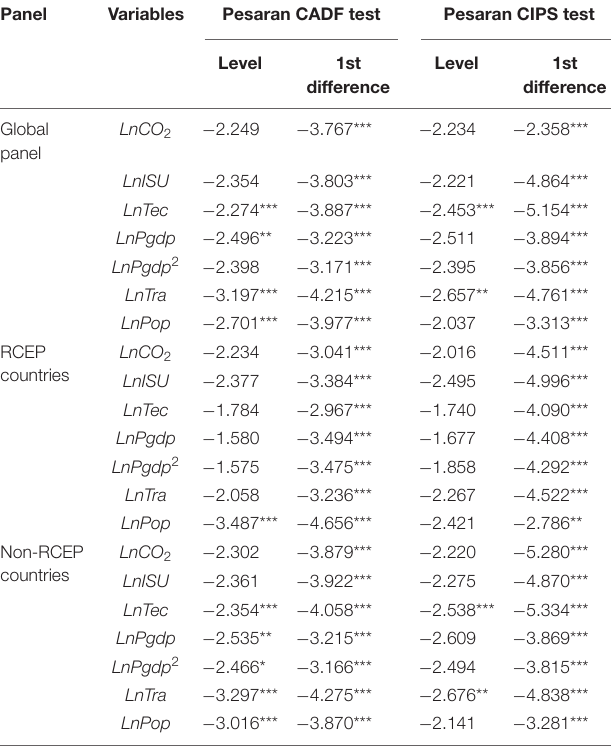
TABLE 4 | Results of the panel CADF and CIPS unit root tests.